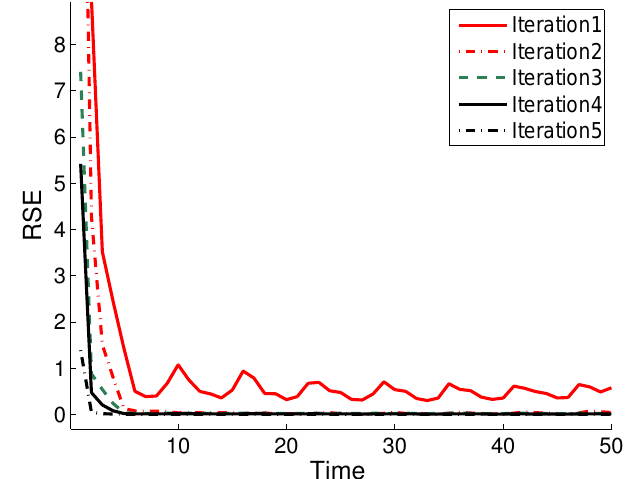
Figure 2. Root square error given by Eq. (33) for the first five Gauss–Newton iterations from the Lorenz 63 problem. The initial conditions for the truth are x( 0 ) = 1, y( 0 ) = 1, and z( 0 ) = 1. The cycle length is d t = 0 . 1 time unit. The observations are the full state at each time step. The ensemble size is N = 100. The assimilation window length is L = 50 cycles. The finite differences parameter is τ = 10 − 3 .